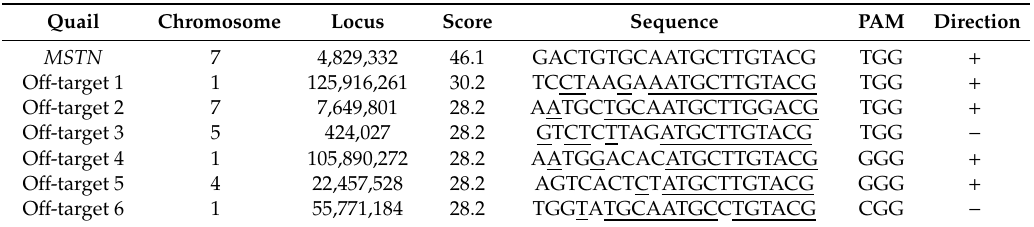
Table A1. Potential o ff -target sites of MSTN gene in Japanese quail genome. Identical nucleotides in potential o ff -target sites are